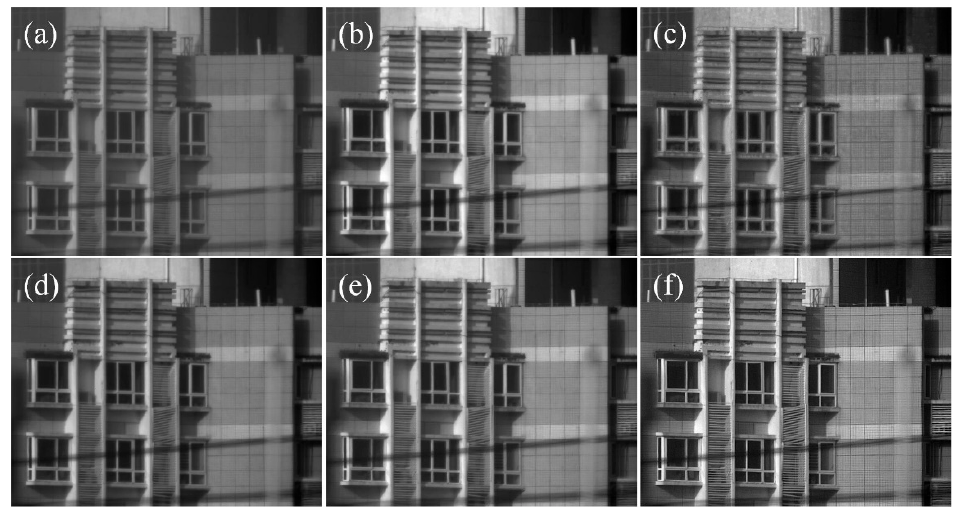
Figure 13. Enhancement results of Image 4: ( a ) input image; ( b ) PE; ( c ) BF&DDE; ( d ) GF&DDE; ( e ) FGF&PE; ( f ) proposed method.